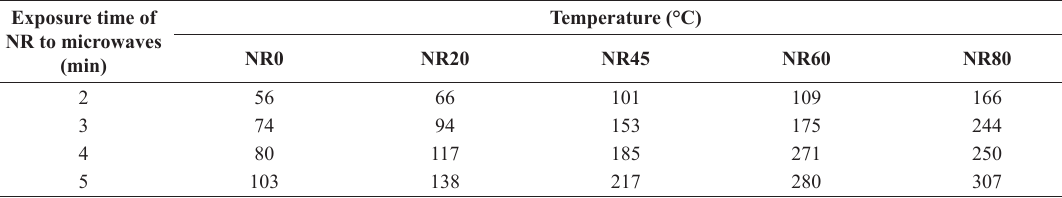
Table 2. Gel content of the samples of NR with controlled composition of carbon black. Exposure time of NR to